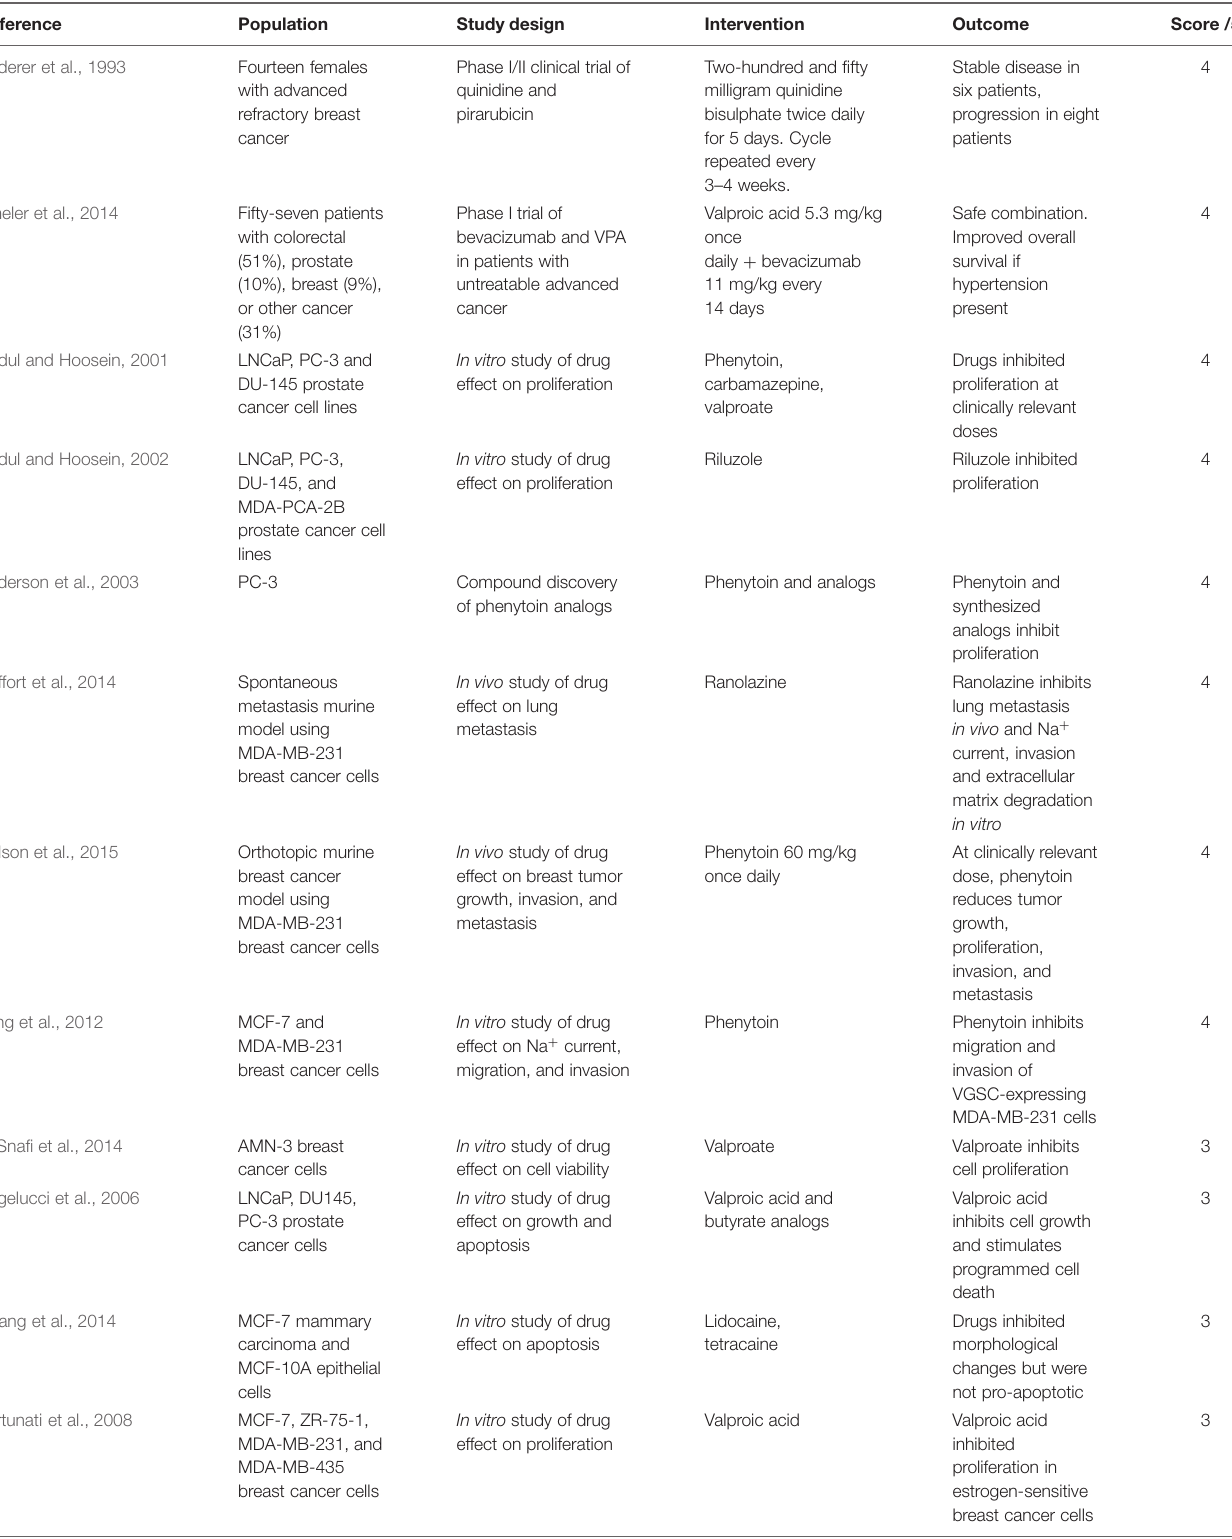
TABLE 2 | Summary of included